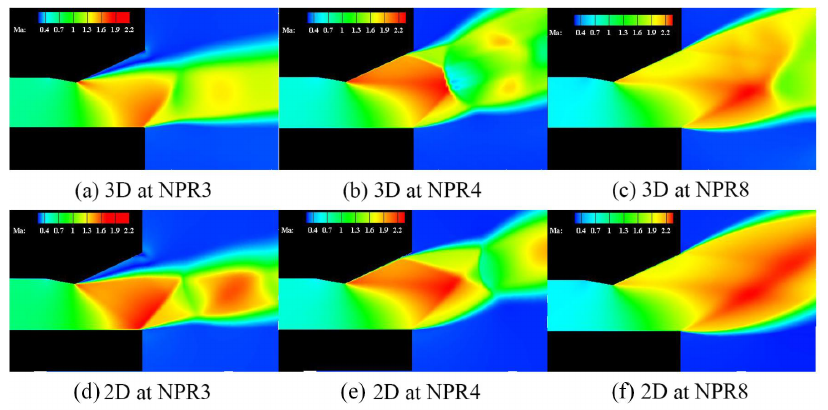
Figure 7. Near-field shock structures of the supersonic jet flows at NPR = 3, 4 and